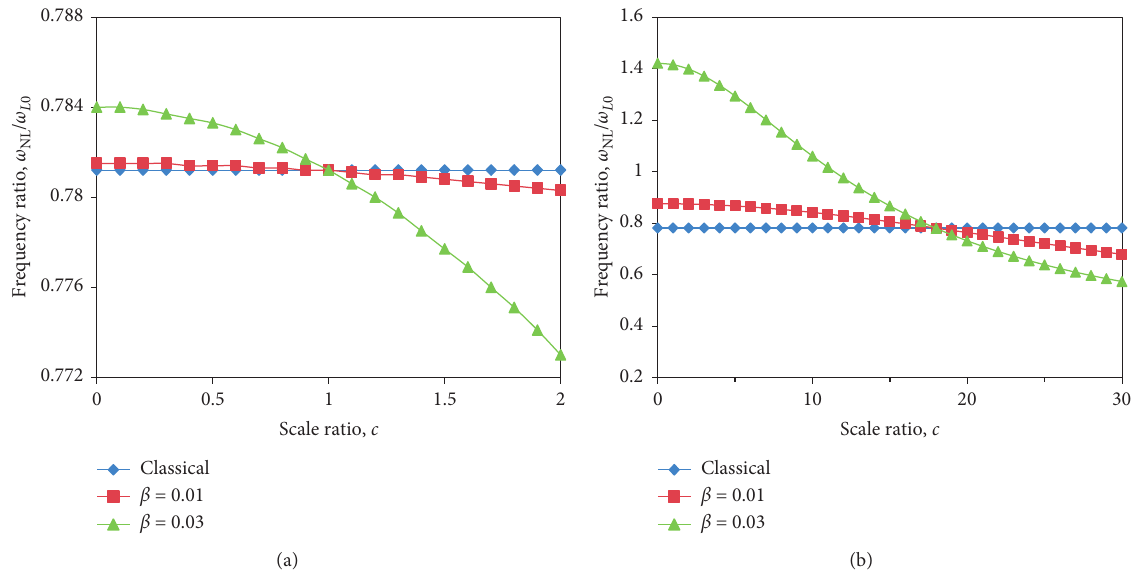
Figure 7: The variation of the frequency ratios of the FG nanobeams to the scale ratio for k � 2, L / h � 15, and V thickness effect; (b) with thickness effect.